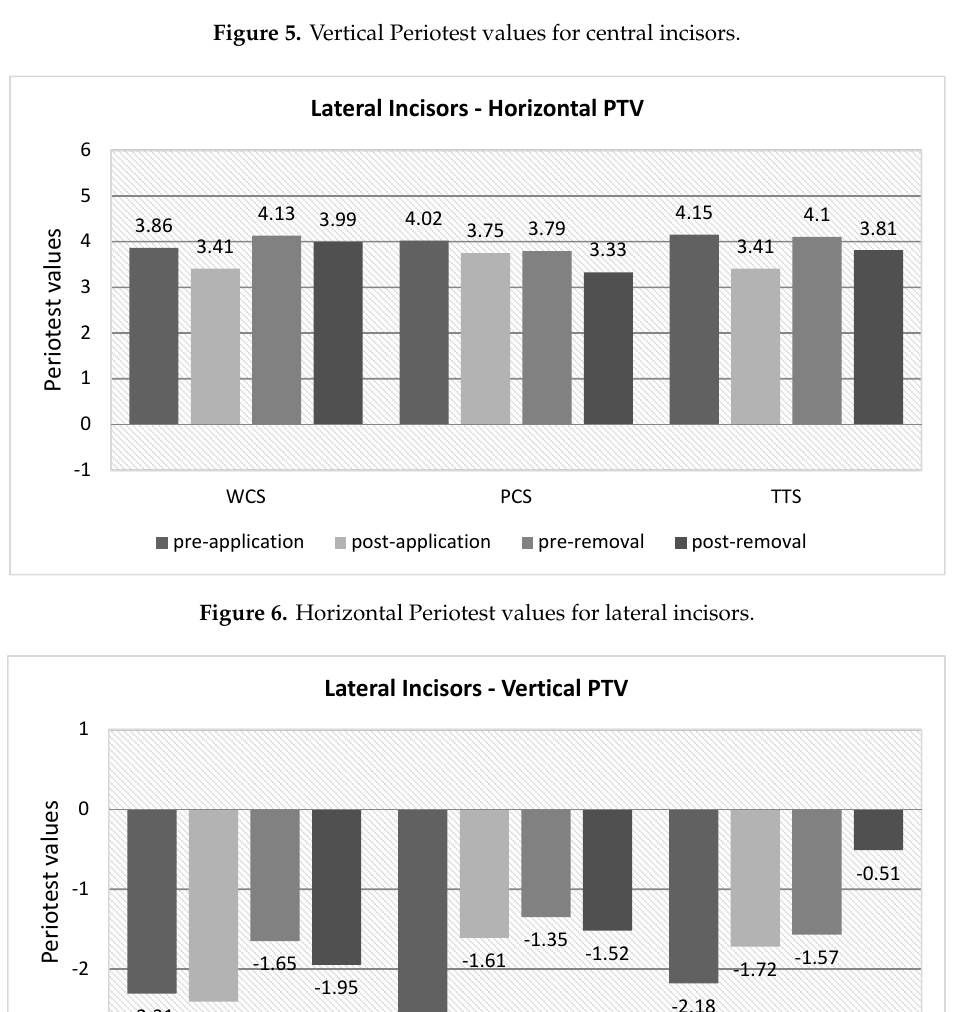
Figure 5. Vertical Periotest values for central incisors. Appl. Sci. 2020 , 10 , x FOR PEER REVIEW